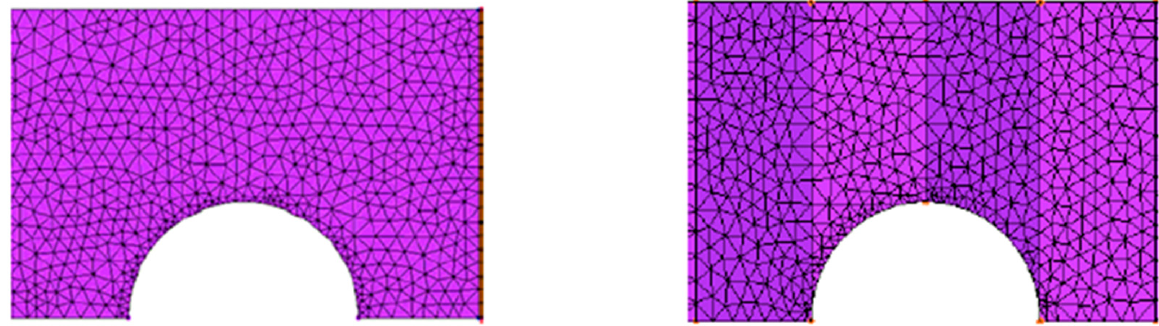
Figure 10. Surface mesh setup for plain and wavy fin configuration [65].